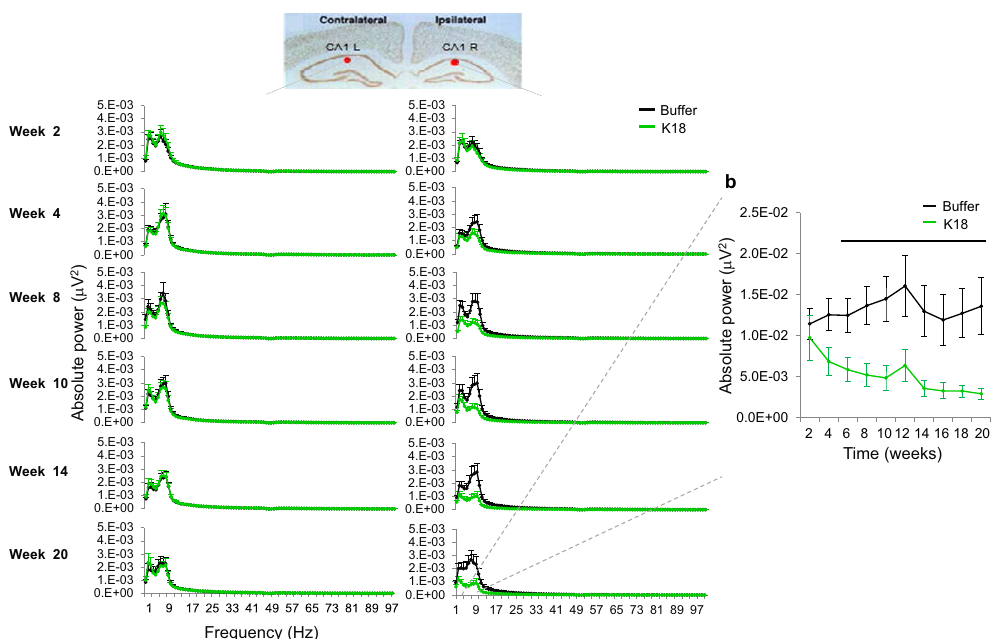
Figure 2. ( a ) Longitudinal mean power spectra in 1–100 Hz from HPC-CA1 injection ipsilateral and their contralateral sites over the second week through to the last recordings (weeks 20) post-administration of buffer (black) and K18 (green). ( b) Early drop of the power spectra in the slow theta frequency band starting on week 4, which became strong on week 20. Data are presented as mean values ± SEM and black bar above curves indicates interval of significant level difference between buffer (black, n = 9) and K18 (green, n = 8) groups. 3 animals across different conditions were discarded from the analysis because of signal